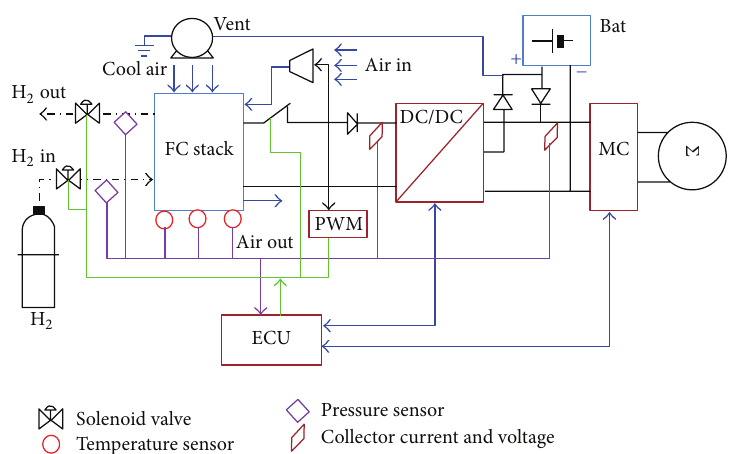
Figure 3: Electrical schematic of the vehicle dynamic